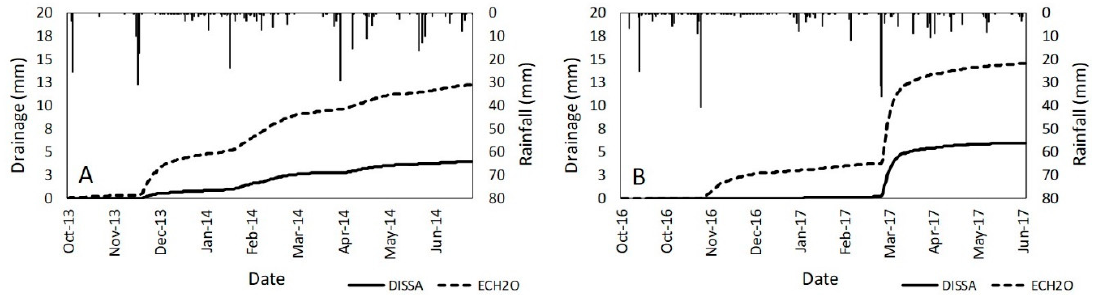
Figure 7. Accumulated drainage (90 cm depth) simulated with LEACHM for the calibration ( A ) and the validation ( B ) periods using different data sets (continuous line from disturbed soil samples and dashed line from ECH2O sensors) in a fallow soil. Bars indicate daily rainfall values for each season.